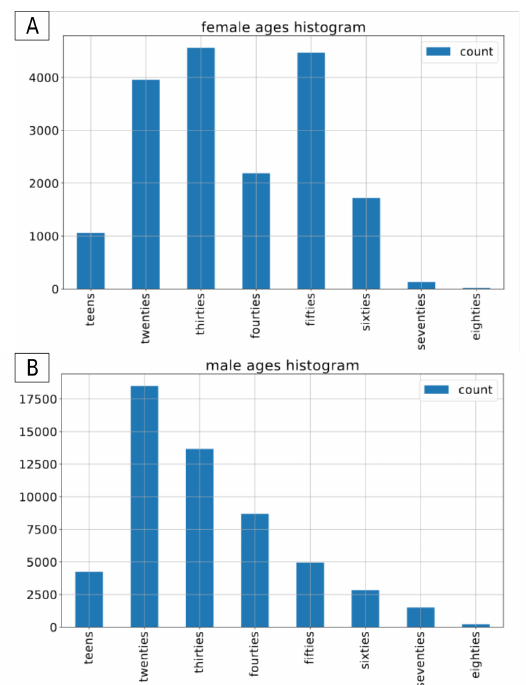
Figure 1. Common Voice: age distribution by gender in the train dataset. ( A ) female speakers, ( B ) for male speakers.